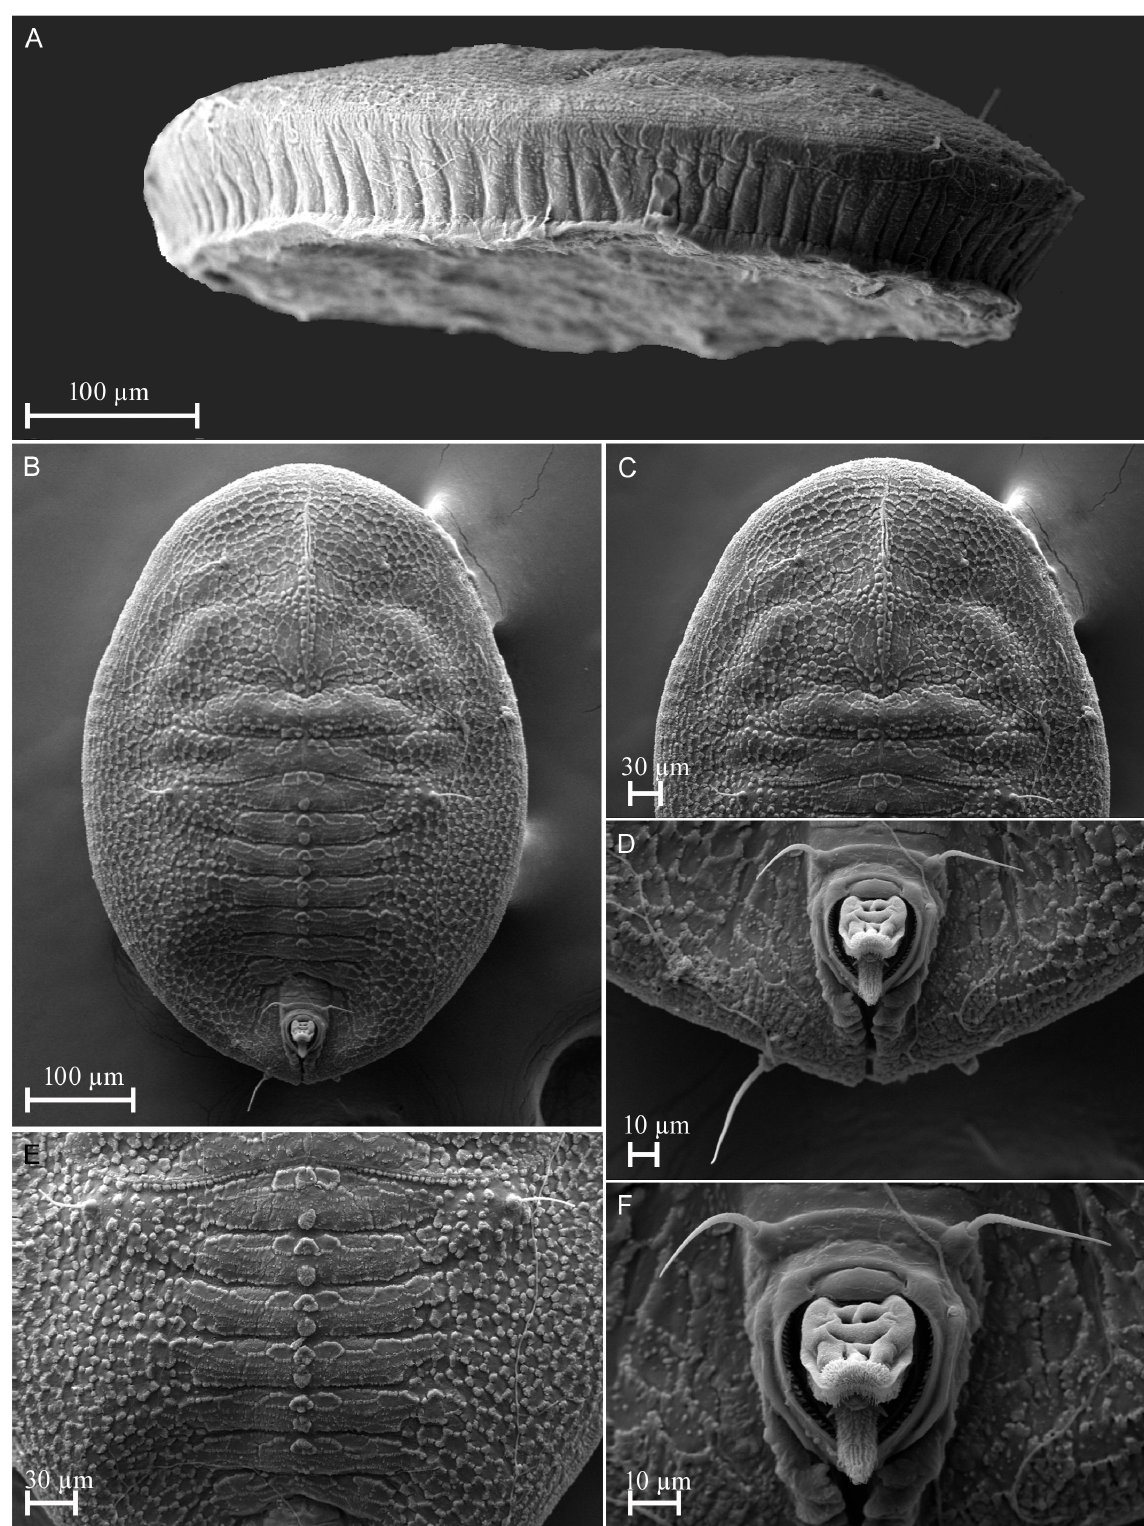
Fig. 5. Rudisculptus caudalis gen. et sp. nov., puparium, not preserved, SEM images. A . Ventrolateral view. B . Dorsal view. C . Cephalothorax. D . Posterior abdominal area. E . Abdominal segment. F . Vasiform